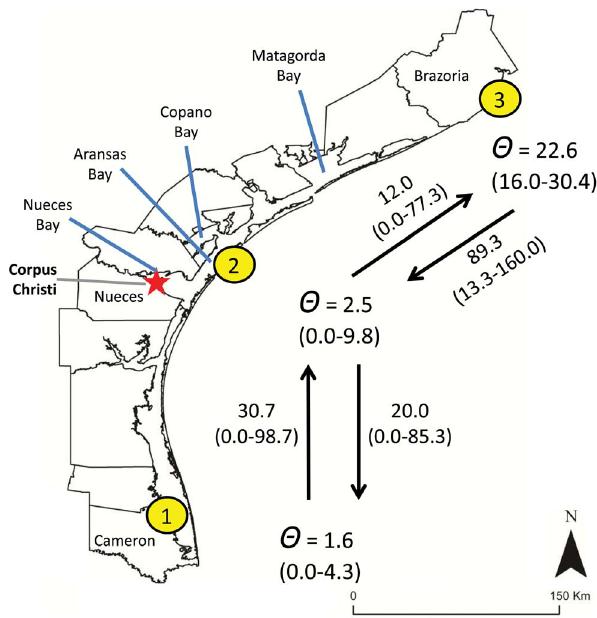
Figure 5. Detailed map of southern Texas showing (1) sampling locations for sites 1–3, (2) bays around Corpus Christi relevant to our discussion of Ammodramusmaritimus cf. sennetti , and (3) estimation of scaled effective genetic population sizes ( h ) and directional migration rates ( ± 95% CIs) estimated with the program MIGRATE - N .